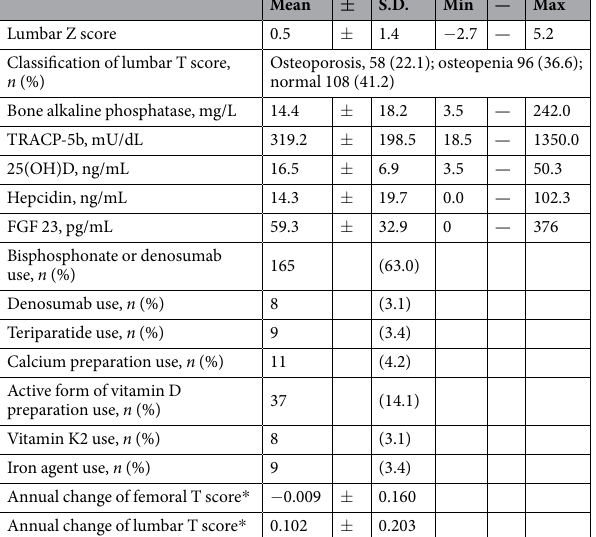
annual change of lumbar T score (Table S3, Fig. 3). Lower hepcidin levels were significantly related to a higher daily PSL dose, a higher rate of bDMARD use, a higher platelet count, and a lower Hb level. Age, disease duration, renal function, TCZ use, BMD, markers of bone metabolism, and FGF23 level were not related to the serum hep- cidin level (Table S3, Fig. 3). Iron metabolism, inflammation due to RA, and the 25(OH)D level were significantly related to the serum hepcidin level.